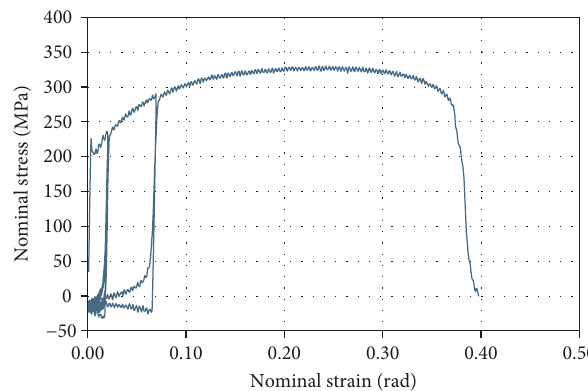
Figure 4: Stress and strain curves for general carbon steel (0.033 mm/sec loading